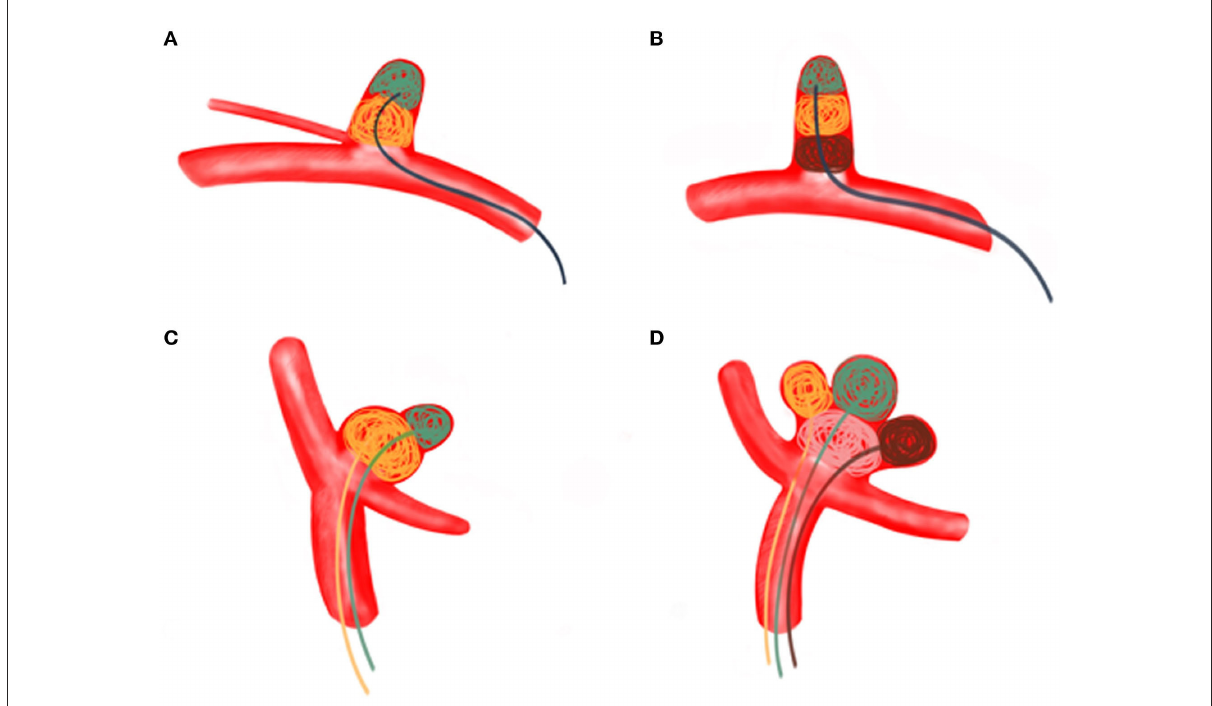
FIGURE6 (A) A regular wide-necked aneurysm was treated using the MCP technique with a single microcatheter. Aneurysm embolization proceeds from the distal part of the aneurysm to the proximal part. (B) The MCP technique of a single microcatheter was used for long, regular arteries involving branch vessels. Aneurysm embolization proceeds from the distal part of the aneurysm toward the proximal part. (C) Dual microcatheter MCP technique was used to treat bifurcated irregular polysaccular aneurysms. The small ruptured sac is embolized first, followed by the embolization of the larger sac (the aneurysm). (D) Irregular polysaccular aneurysm was treated with multi-microcatheter MCP technique. Aneurysm embolization is performed from the individual sub-sacs of the